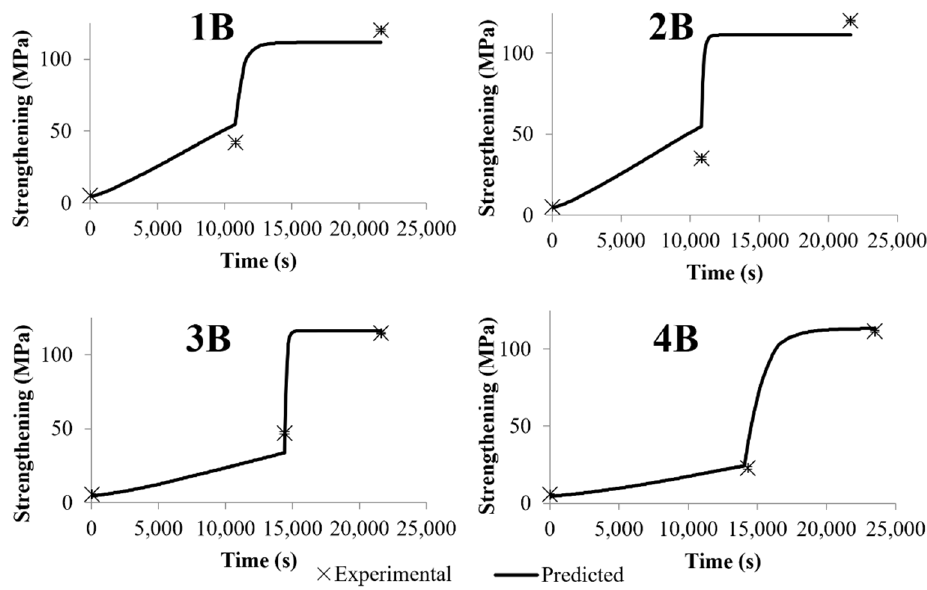
Figure 6. Graphs demonstrate the experimental and simulated results of several two ‐ step heat treat ‐ ments for Al ‐ 0.07Sc at%, as described in Table 2. Error bars represent +/ − 2 standard error.